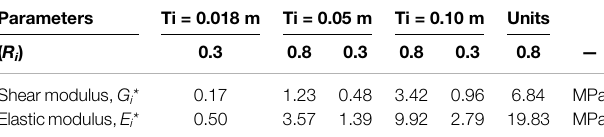
TABLE 3 | Stiffness interface properties for t i = 0.018 m (previous analyzed cases),